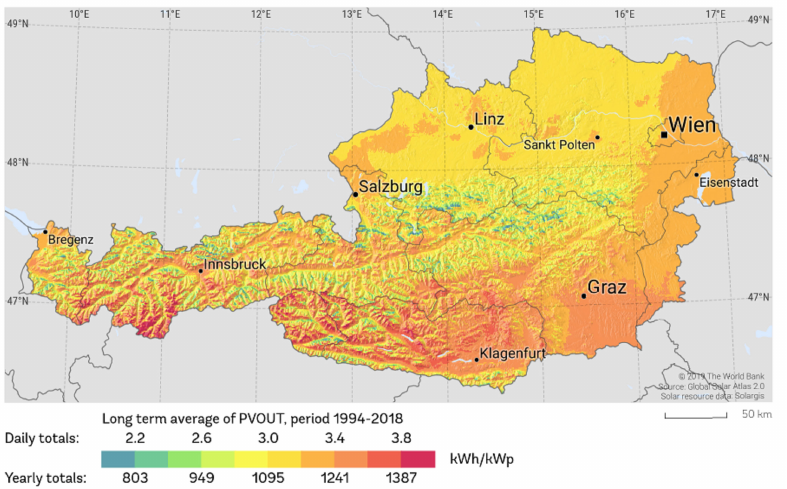
Figure 7. Horizontal solar power potential in Austria (© 2020 The World Bank, Source: Global Solar Atlas 2.0, Solar resource data: Solargis [68] SolarGIS